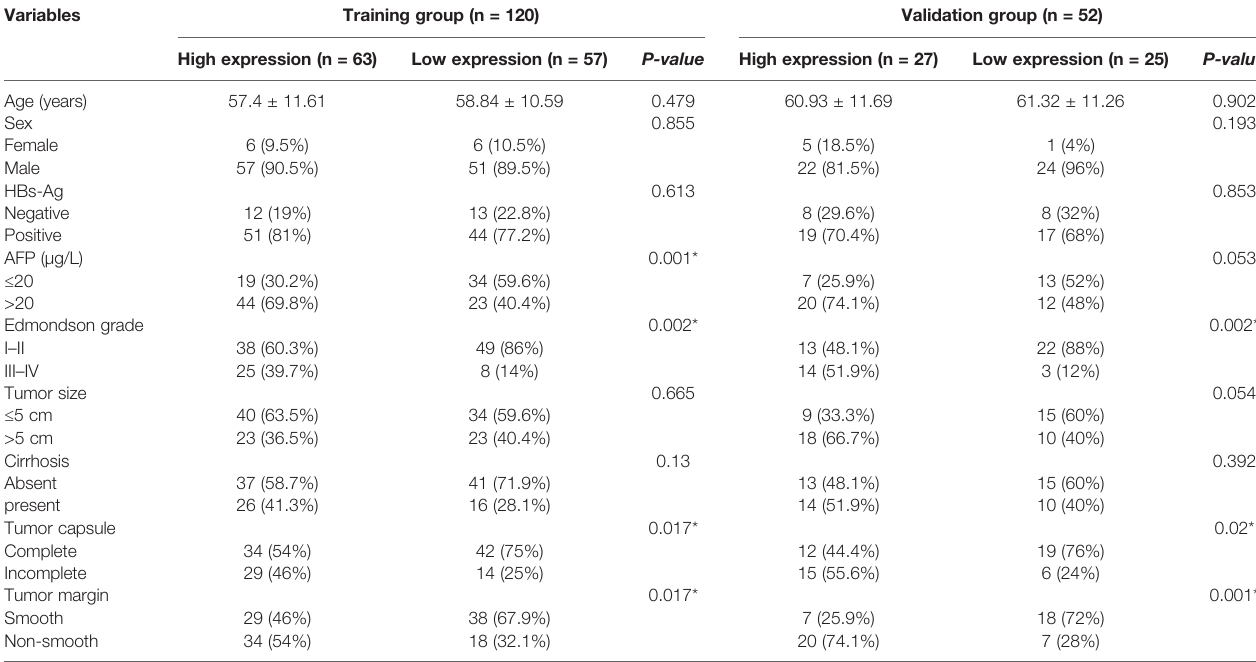
TABLE 1 | Characteristics of HCC patients in the high and low Ki-67 expression groups. Variables